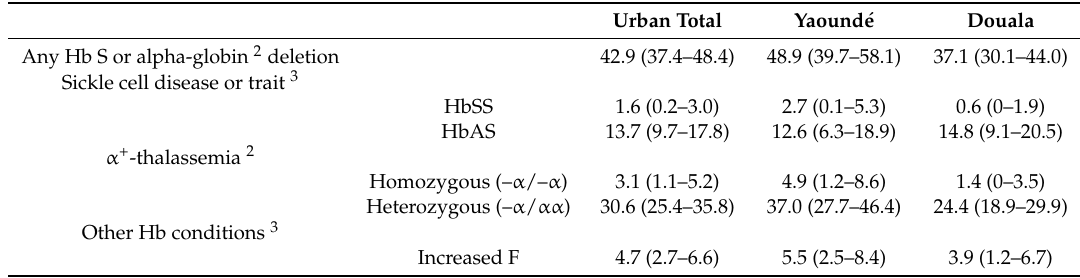
Table 2. Prevalence of inherited hemoglobin disorders among a representative sample of children 12–59 months of age in Yaoundé and Douala, Cameroon 1 .